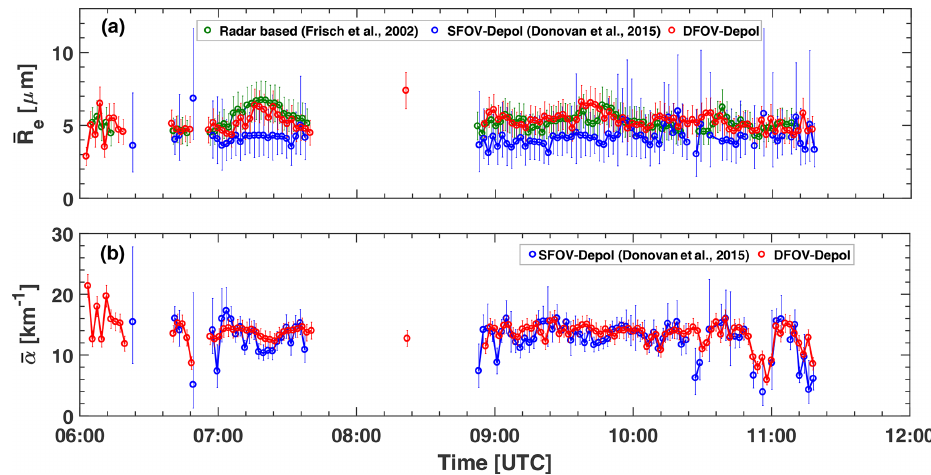
Figure 6. Comparison of (a) droplet effective radius values R e (mean values for the lowest 100m in the liquid-water cloud layer) and (b) respective mean extinction coefficient values α obtained with the single-FOV polarization lidar method (SFOV-Depol) (Donovan et al., 2015) and the dual-FOV polarization lidar technique (DFOV-Depol) for the case shown in Fig. 4. In addition, the results (in green) obtained with a cloud radar approach (Frisch et al., 2002) are shown in (a) . Observations of the radar reflectivity factor performed with the LACROS 35GHz cloud radar at Punta Arenas are used here. Error bars indicate the uncertainty